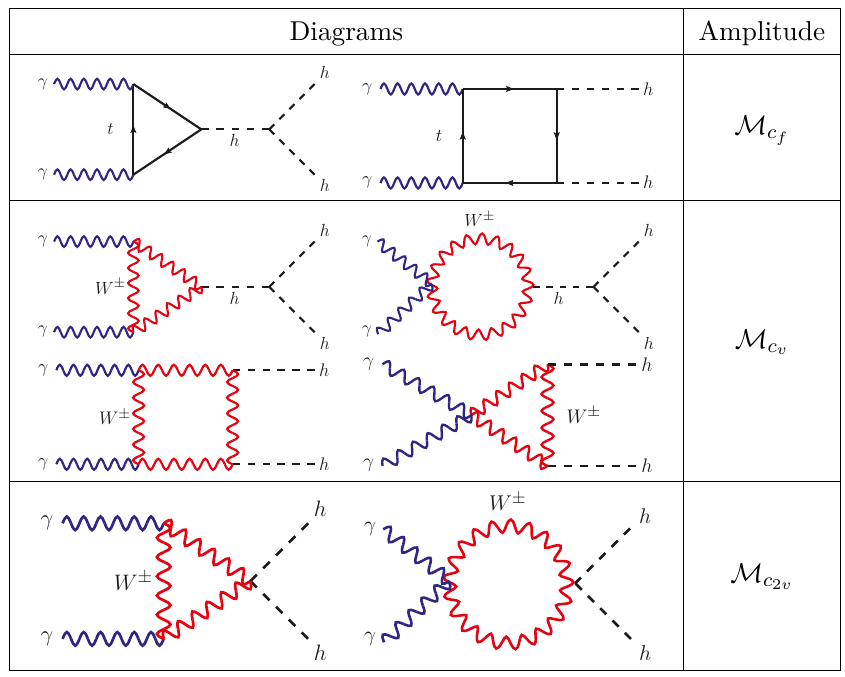
Table 1 . Diagrams for the di-Higgs production at a photon collider ( γγ → hh ) in the SM, with the corresponding partial amplitudes as defined in the